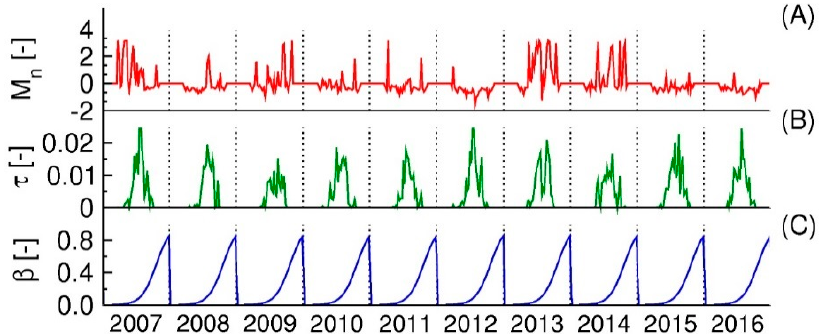
Figure 5. Time series for key variables used to predict the dynamic of human disease cases from 2007 to 2016. The three panels display time series of transmission factors used for the model of human disease cases. Panel ( A ) shows normalized mosquito numbers ( M n ); Panel ( B ) transmission rate of the virus ( τ ) of mosquitoes; and Panel ( C ) feeding patterns of a mosquito on humans ( β ). All the variables have a weekly basis.